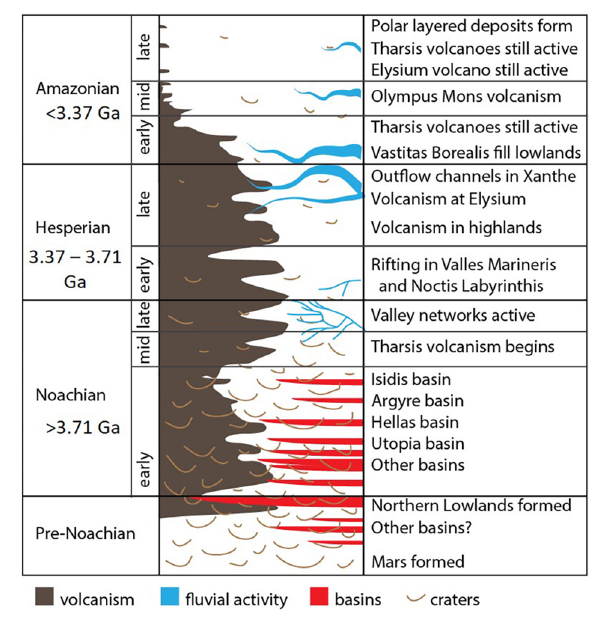
FIGURE 5 | Mars’ detailed geologic time scale showing the occurrence of geological events (Werner and Tanaka, 2011; Michael, 2013; Lagain et al.,